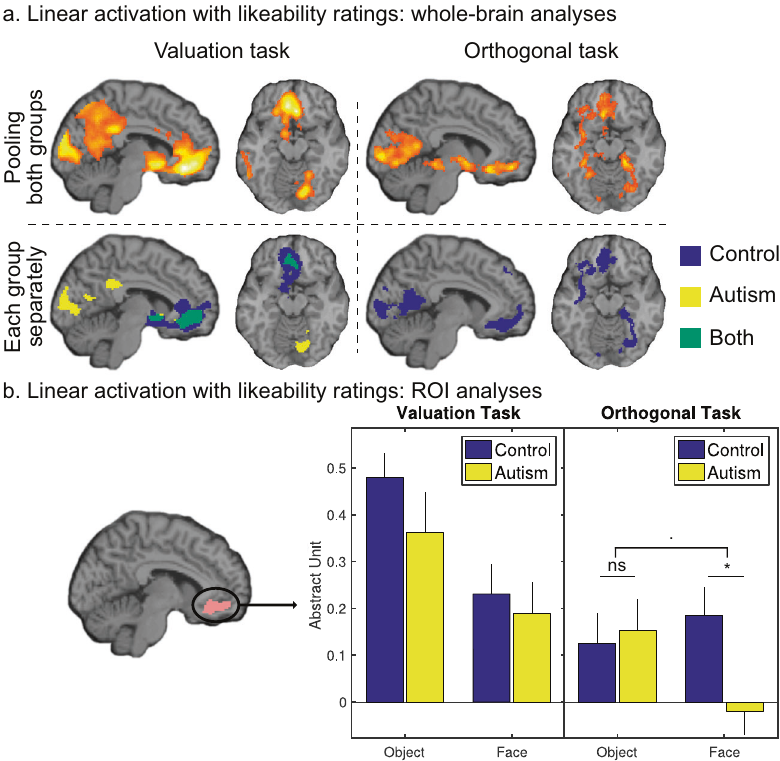
Fig. 4 Neural value signals. a Whole-brain analysis. Statistical Parametric Maps show linear activation with likeability ratings, pooling all participants together (top panels) or in each group separately (bottom panels — blue: control participants, yellow: autistic participants, green: both groups). Note that likeability ratings were expressed during scanning for the valuation task (left panels) and after scanning for the orthogonal task (right panels). b ROI analysis focusing on the vmPFC (left map). Likeability regression estimates were extracted during the valuation task (left barplot) and during the orthogonal task (right barplot) for each participant and then compared between tasks and groups. Error bars represent inter-participant